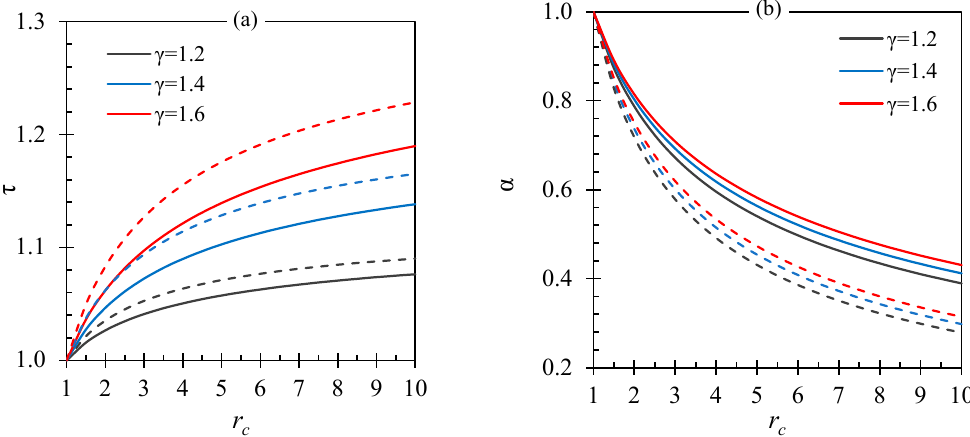
Figure 6. Dimensionless temperature of the driving gas at the end of the compression stroke ( a ) and efficiency of the driving gas use ( b ) as a function of the compressor pressure ratio and different γ ; γ c = 1.4, r = 3; solid lines—adiabatic compression, dashed lines—isothermal compression.